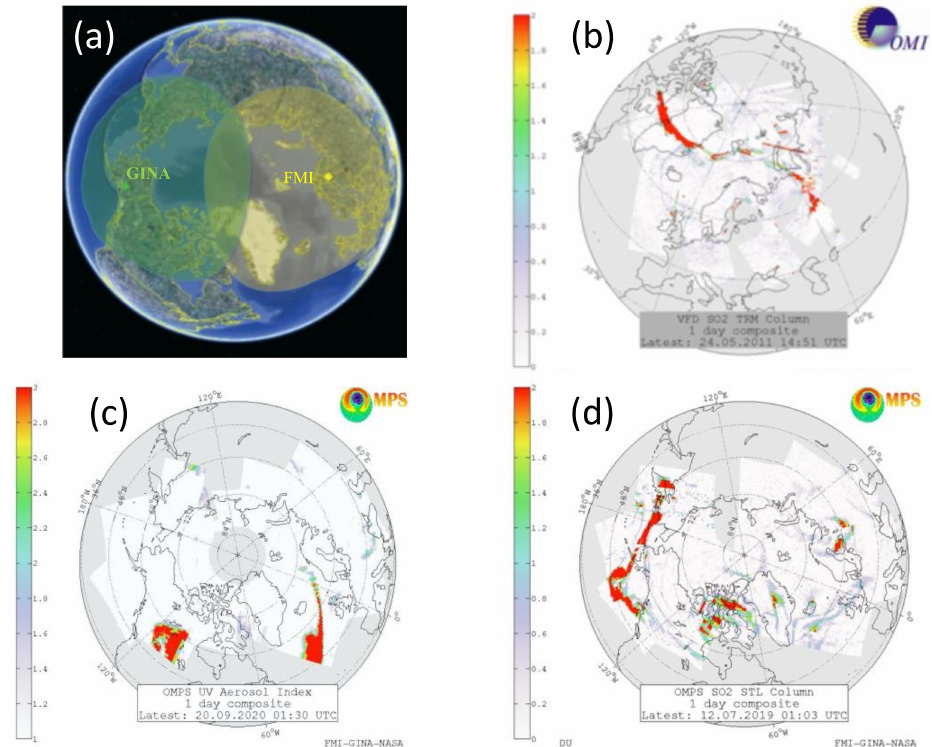
Figure 10. ( a ) Direct readout coverage of the NASA EOS Aura Ozone Monitoring Instrument (OMI), SNPP, and NOAA20 direct broadcast received via the FMI satellite downlink station in Sodankylä in northern Finland (yellow) and GINA ground station in Fairbanks, Alaska (green). ( b ) Several OMI orbits composite SO 2 map showing long-range SO 2 transport (red) from the May 2011 Grimsvotn eruption in Iceland. ( c ) OMPS composite UV Aerosol Index (UVAI) map showing the long-range transport of September 2010 forest fire smoke clouds from the US West Coast. ( d ) OMPS composite SO 2 map showing the dispersion of SO 2 clouds from the 2019 Raikoke eruption. Currently, both OMI and OMPS volcanic SO 2 and UVAI maps are processed and made available at the FMI SAMPO website (https://sampo.fmi.fi/products accessed on 5 October 2021) within ~30 min of satellite